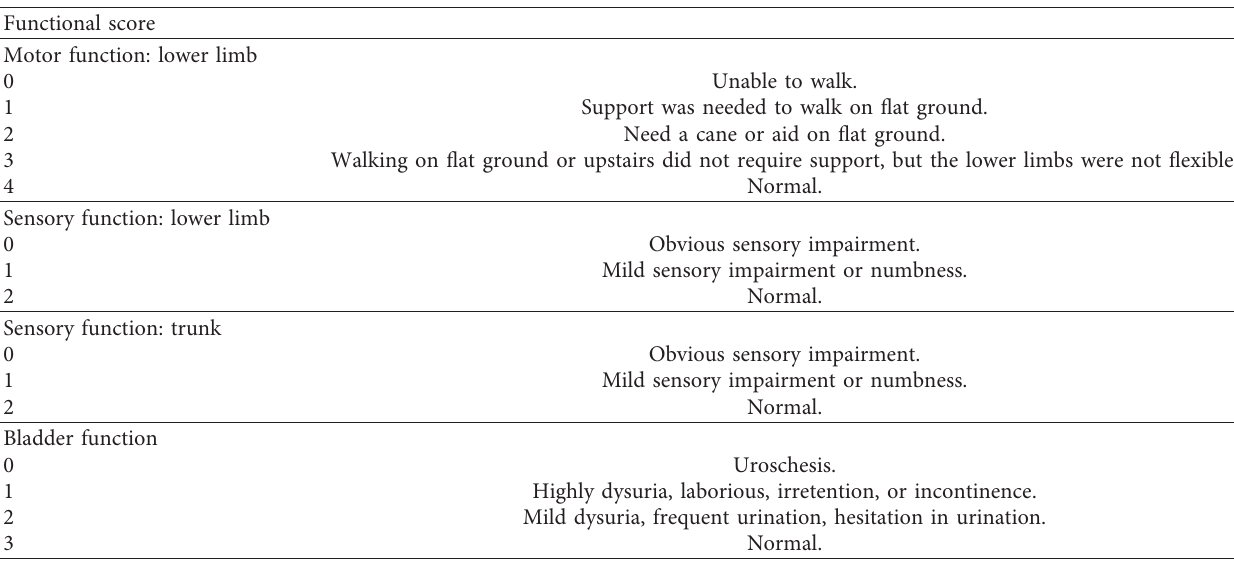
Table 2: Modified Japanese Orthopaedic Association (JOA) scoring system for the assessment of thoracic myelopathy (total score 11 points).